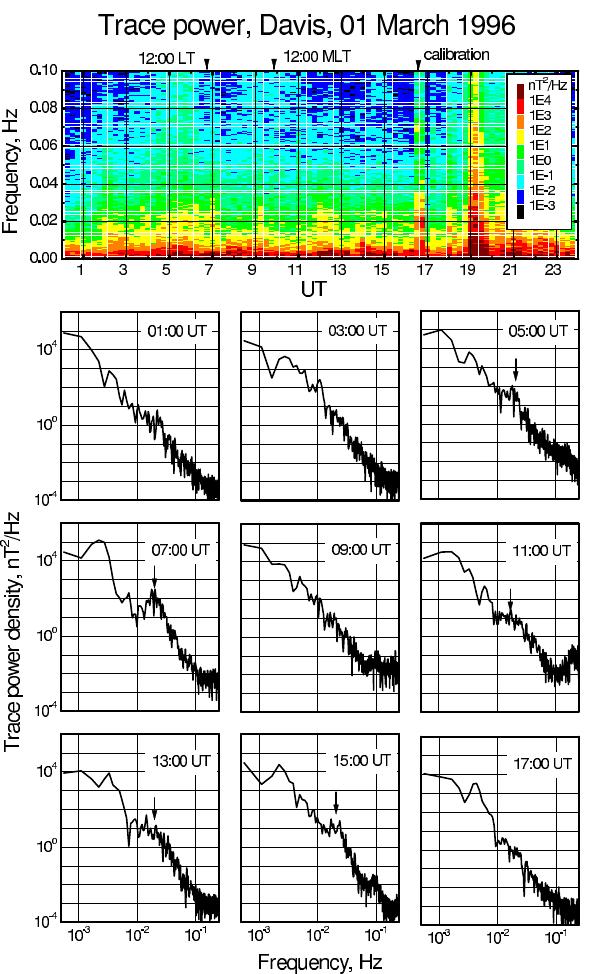
Fig. 2. Average diurnal spectrogram and power spectra for all of 1996 in the same format as Fig. 1. Line thickness of the power spectra correspond to the 95%-confidence limits. Dotted lines rep- resent S ∝ f − 4